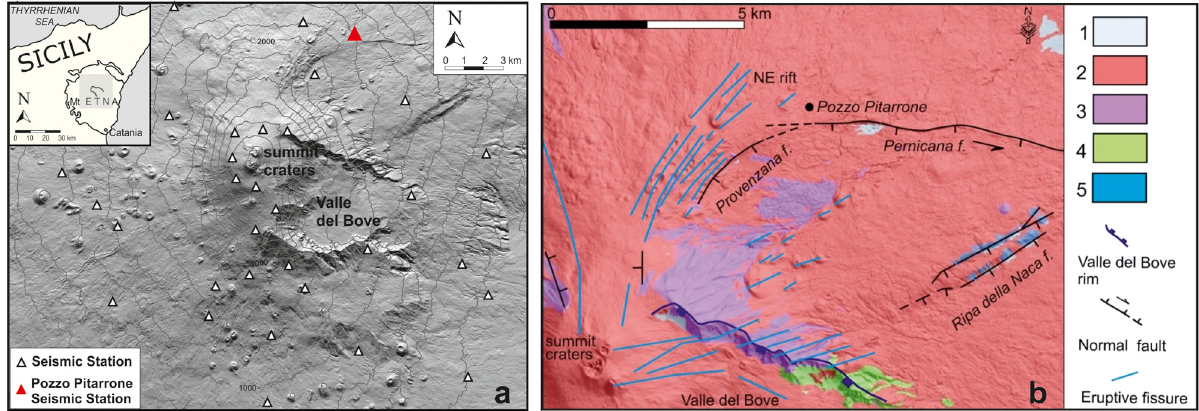
Figure 1. (a) Mt. Etna with the permanent seismic network and the position of Pozzo Pitarrone array (red triangle). (b) Geological and structural sketch map of Etna volcano (modified from Branca et al. [2011]): 1) present and recent alluvial deposits; volcanic products of the Stratovolcano phase: 2) Mongibello volcano (<15ka); 3) Ellittico volcano (60ka-15ka); 4) volcanic products of the Valle del Bove phase (110ka-60ka); 5) volcanic products of the Timpa phase